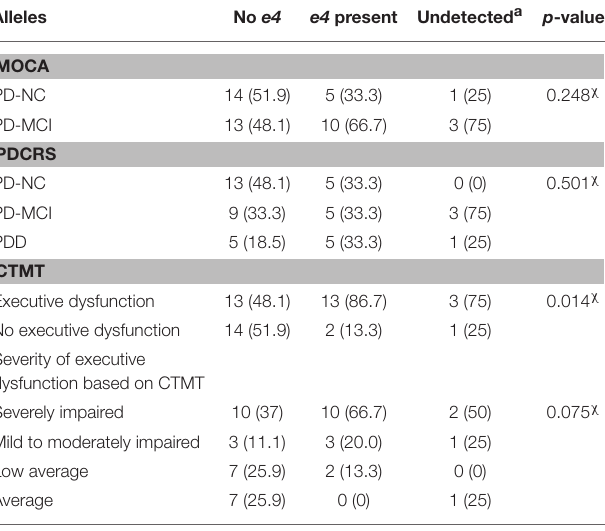
TABLE 4 | Distribution of ApoE genotypes and e4 alleles based on MoCA and PDCRS.